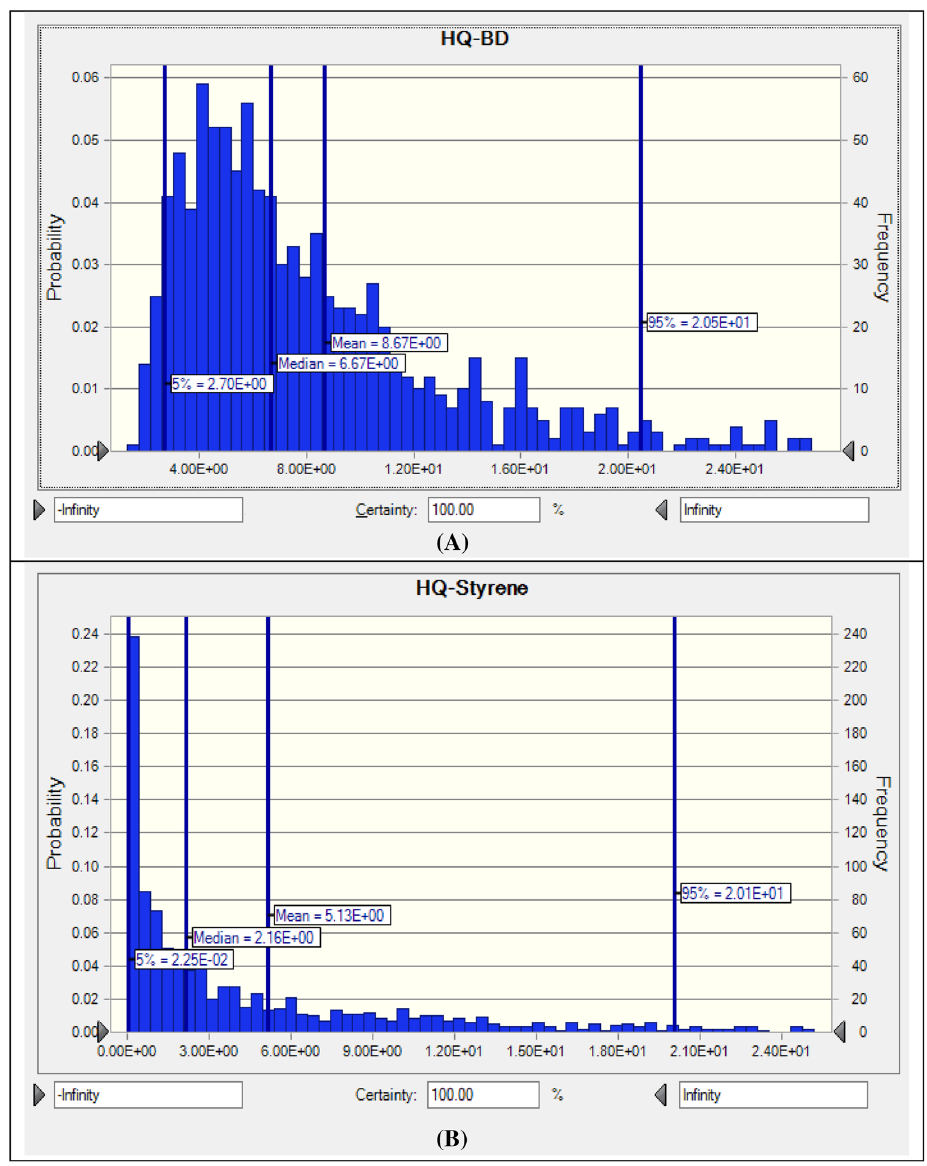
Figure 2. The non-cancerogenic risk for ( A ) 1,3-butadiene (BD), ( B ) Styrene